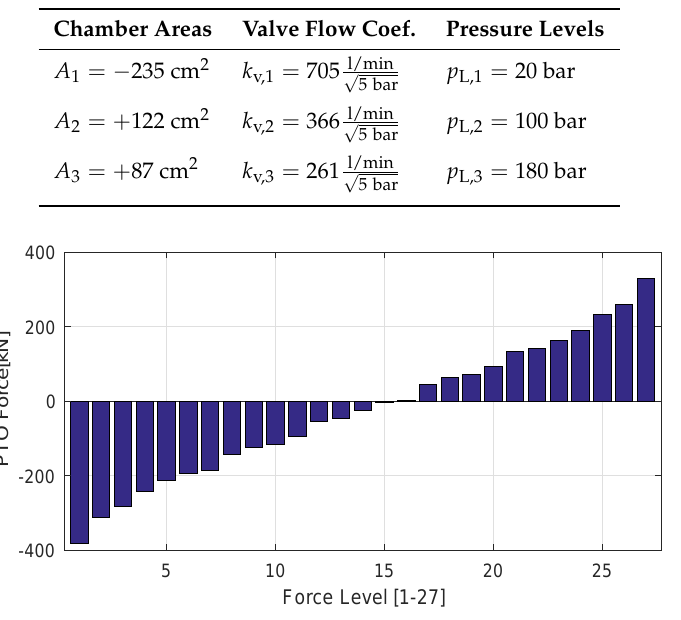
Table 2. Discrete PTO system parameters. The sign of the areas indicates the force direction. Chamber Areas Valve Flow Coef.